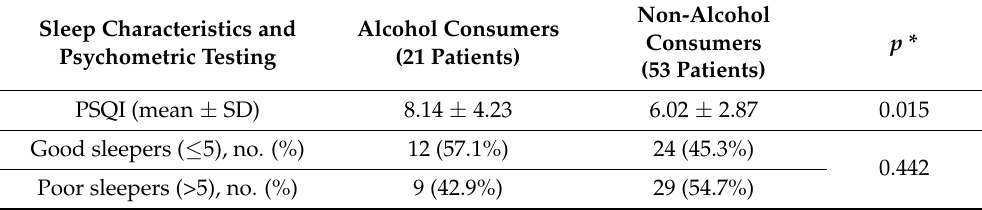
Table 8. Sleep evaluation and psychometric testing of patients with alcohol consumption in compari- son with those without alcohol